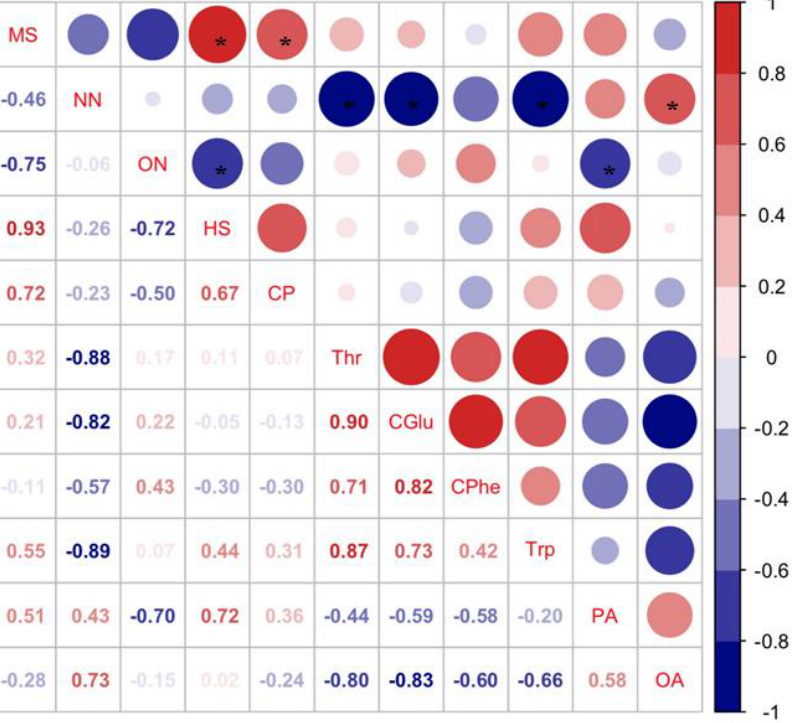
Figure 7. Pearson correlations between key VOCs in soybean and host selection and nutrients of C. bilineata tsingtauica larvae (MS: methyl salicylate; NN: nonanal; ON: 3-octenol; HS: host selection; CP: crude protein; Thr: threonine; CGlu: glutamic acid in C. bilineata tsingtauica ; CPhe: phenylala- nine in C. bilineata tsingtauica ; Trp: tryptophane; PA: palmitic acid; OA: oleinic acid). The size of the blocks corresponds to the values in the figure, which represent the correlations between key plant VOCs and larval host selection and nutrients. Red blocks indicate positive correlations, blue blocks indicate negative correlations, and the asterisks within the blocks indicate significant correlations at p < 0.05. 4. Discussion Plant nutrients play an important role in the growth, development and nutritional quality of insects. This study indicates that soybean nutrients might improve the nutrition of C. bilineata tsingtauica larvae. Guo et al. [11] also found that plant nutrients were posi- tively correlated with insect nutrition. Similarly, the western flower thrip ( Frankliniella oc- cidentalis ) prefers plant pollen to leaves because of the higher protein content [32]. Bradysia cellarum and Bradysia impatiens also showed a nutrient preference for the chives and B- beans with higher levels of protein, amino acids, SS and starch than other plants. The con- tents of SS, lipid and protein were significantly higher in the two Bradysia species fed on chives and B-beans than in those fed on cabbage, lettuce, W-cabbage and pepper [33]. In addition, Glu in poplar leaves inhibits the growth and development of H. cunea [16]. Die- tary supplementation of Glu shortened pupal duration and increased pupal weight in honey bees ( Apis mellifera ) [34]. The amino acids in soybean plants and C. bilineata tsing- tauica larvae were both measured using an amino acid analyzer, including cysteine, which was fully recoverable by the analyzer. We speculated that the content of Thr, Glu, and Phe in the insects could be increased by regulating the Glu in the host plants, thus contributing to the improvement of overall amino acid levels in C. bilineata tsingtauica . Moreover, stud- ies have shown that PA and OA are the predominant fatty acids in some edible insects (e.g., Hermetia illucens , Polistes sp., Dactylopius sp., Euschistus taxcoensis , Euschistus strenuus , etc.) [35–37]. OA has a beneficial effect on blood vessels reducing the risk of cardiovascular